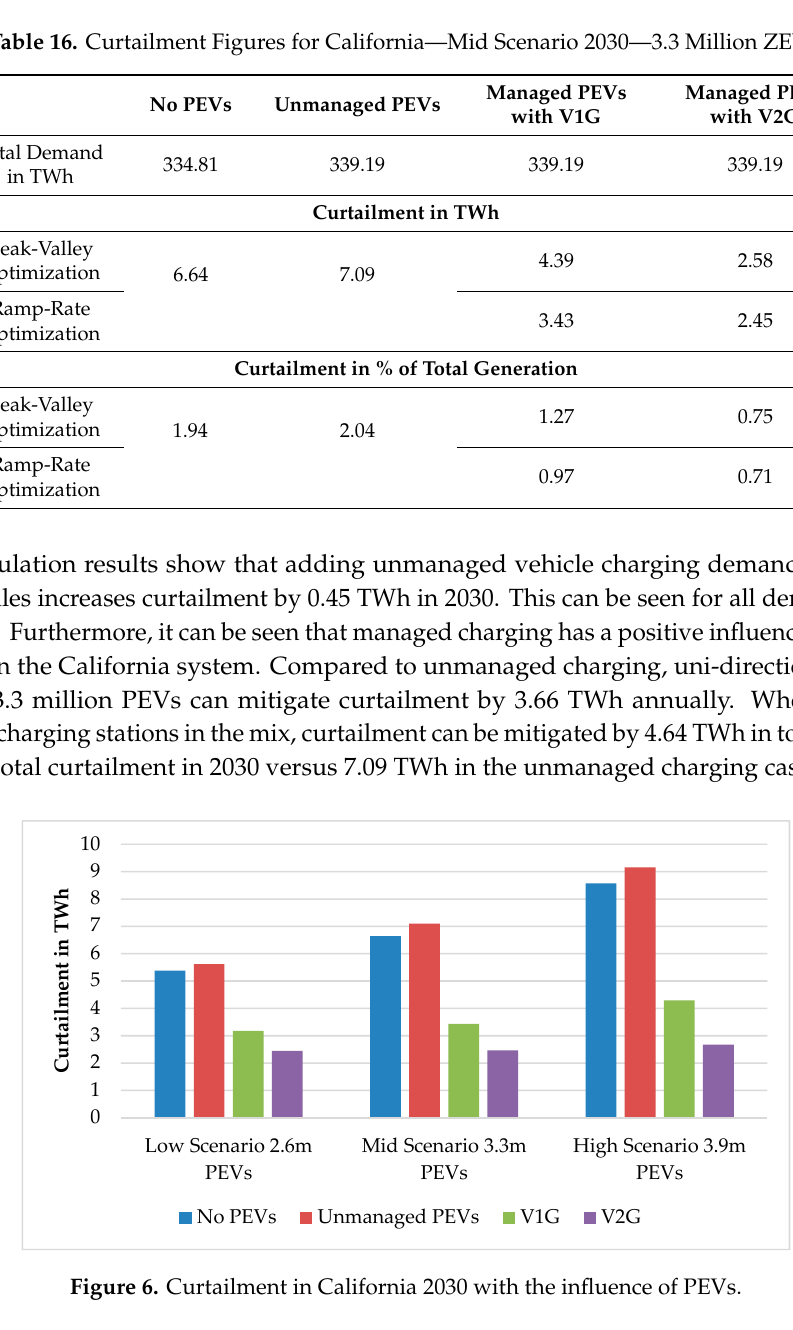
Figure 7. California Managed Charging: April 2030—Mid Scenario—Ramp-Rate Mitigation. The unmanaged charging line in Figure 7 is the base case that represents the net load when PEV charging is not managed or influenced by grid operators. The maximum downward ramp can be seen between 6 am and 9 am with 11 GW in 3 h. The maximum upward ramp can be seen between 2 pm and 5 pm with 17 GW in 3 h. This approximately 13 GW ramp level in 3 h is already causing challenges from a grid operator perspective. The unmanaged charging case exceeds this challenge by 4 GW, most likely creating grid operation problems in the future. Especially, V2G charging seems to have immense potential to help shape system electricity demand through its capabilities to feed energy back to the electricity grid when general electricity demand is high. Uni-directional V1G